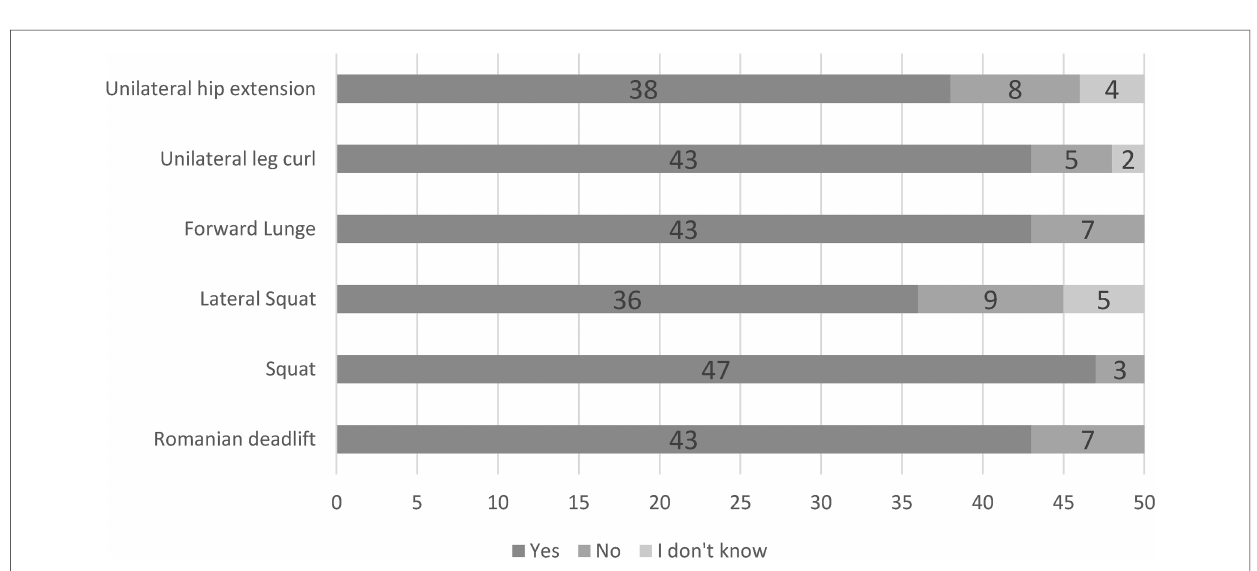
FIGURE 5 The use of lower body fl ywheel exercises amongst therapists working in sport. N